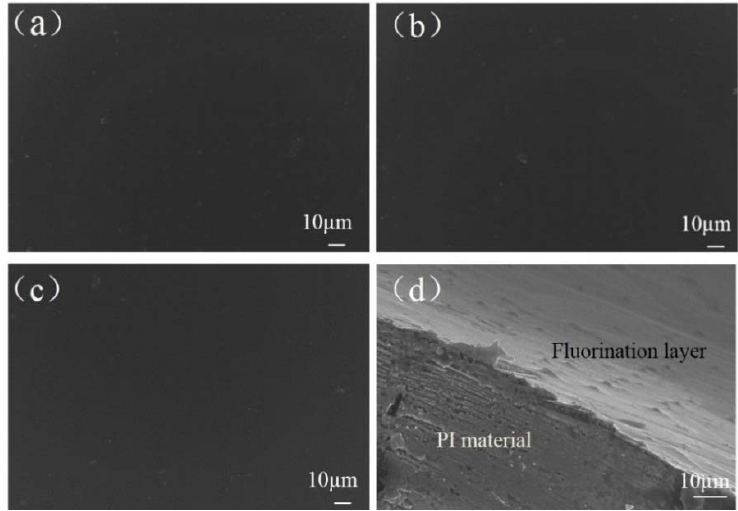
Figure 11. Surface morphologies of the PI dielectrics with fluorination time of ( a ) 0 min, ( b ) 30 min and ( c ) 60 min, cross ‐ section morphology of ( d ) 60 min fluorinated dielectric.